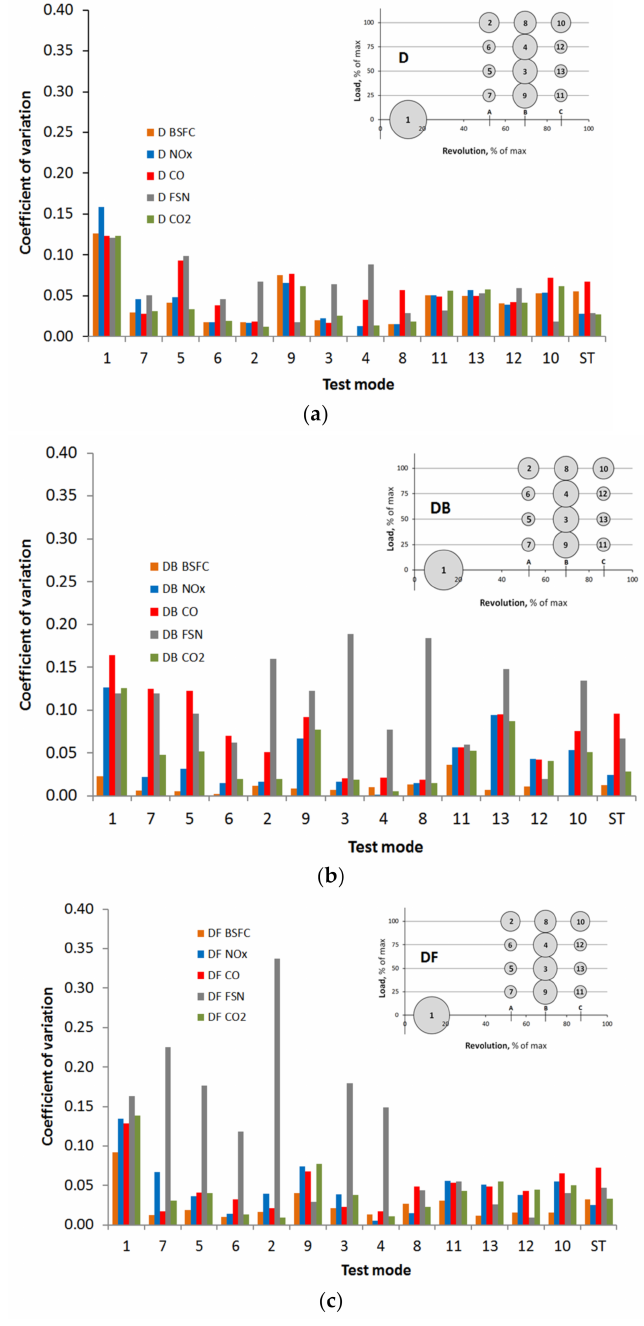
Figure 10. Values of the coefficient of variation in each test mode and in the sum of the ESC test (ST) of engine fed with D fuel ( a ), with DB ( b ), and with DF ( c